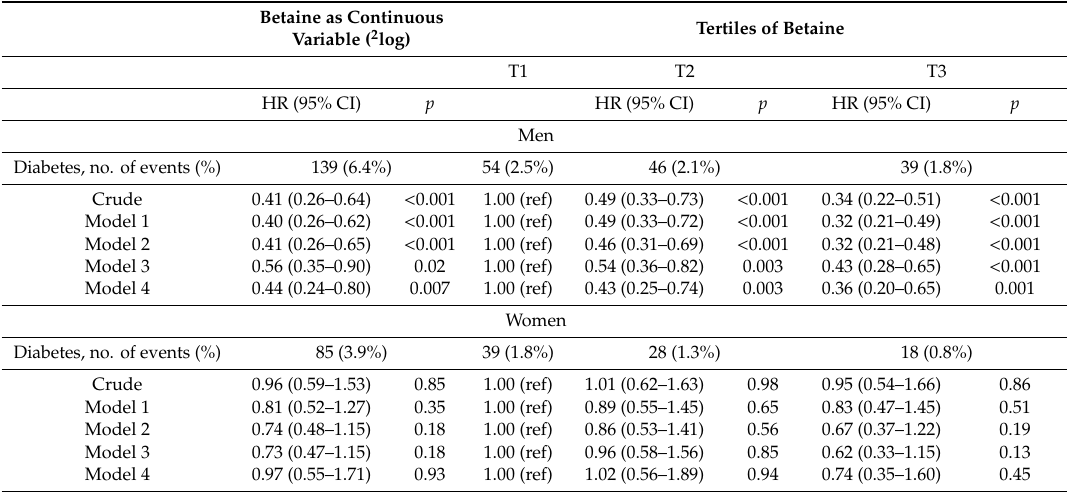
Table 5. Sex-stratified analyses of the association of betaine as a continuous variable and according to tertiles with the development of